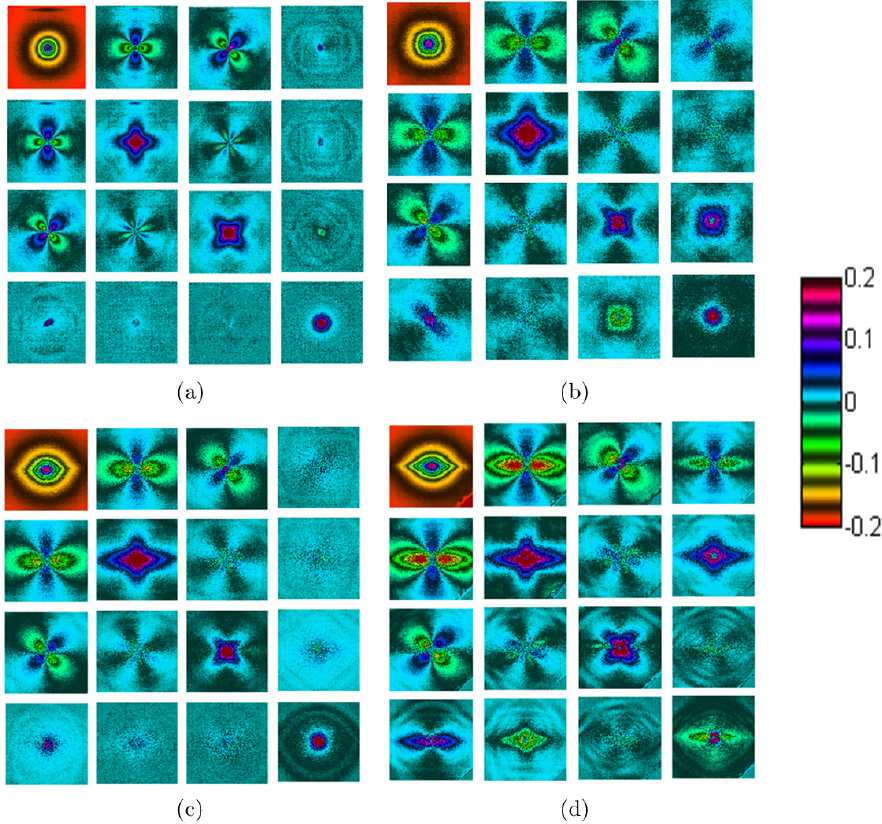
Fig. 3. Experimental backscattering Mueller matrices of (a) sphere scattering medium, (b) sphere birefringence medium, (c) sphere-cylinder scattering medium and (d) sphere-cylinder birefringence